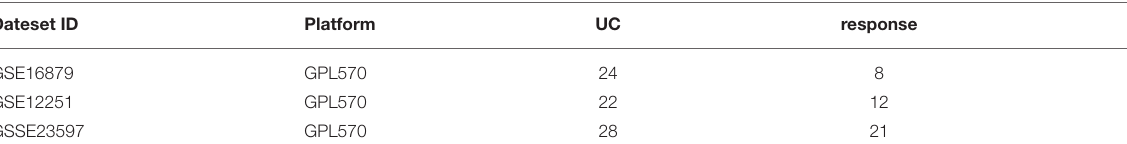
TABLE 1 | The information of training/validation datasets.